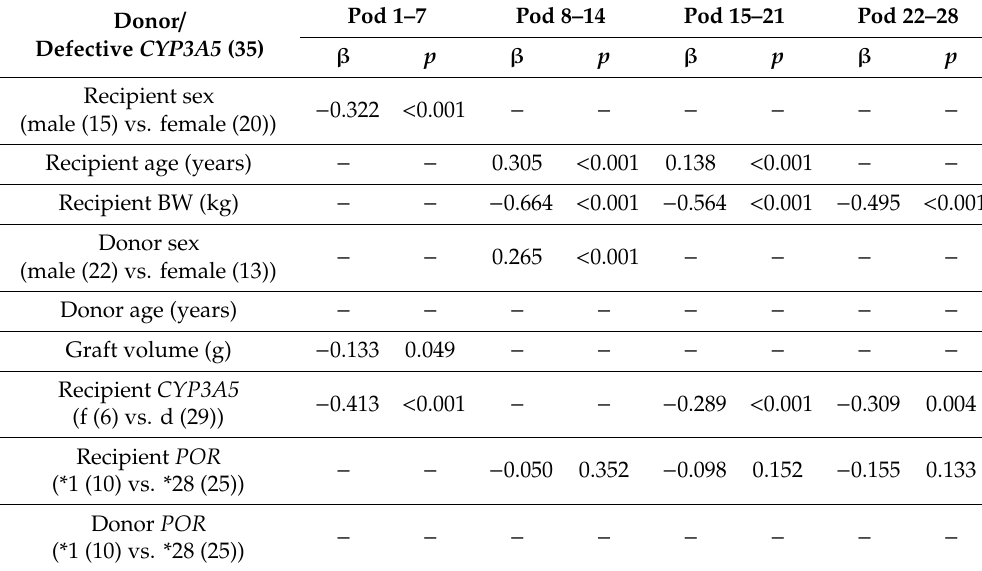
Table 8. Multiple regression analysis of cases in which donors had defective